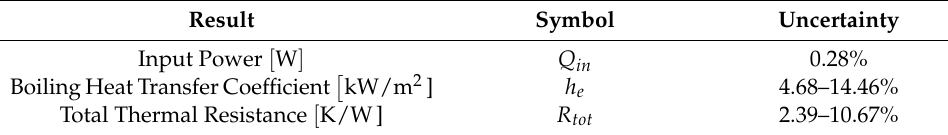
Table 3. Uncertainty of experimental